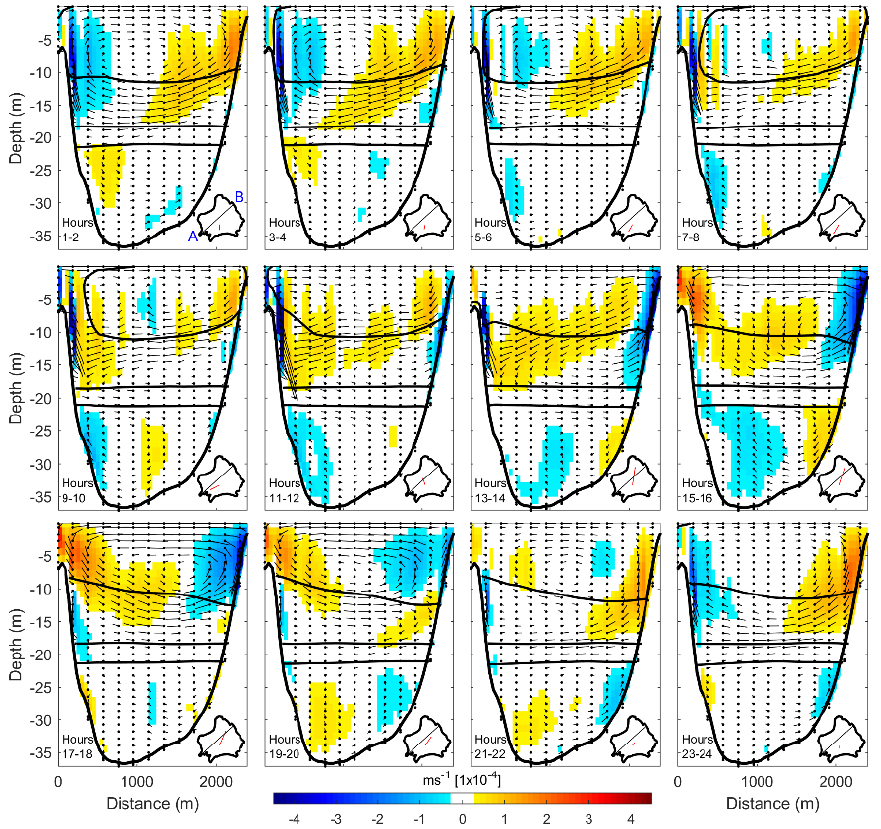
Figure 18. Same as Figure 17 for a vertical transect across Lake Zirahuén. The composites of the simulated velocity current (vectors), vertical velocity component (color), water temperature (contour lines of 18, 20, and 22 °C) and wind speed (vector at the lower right corner of every axes). The transect from A to B in the lower right corner of every axes. The velocity current vectors are shown with a dot at the tail and without arrowhead. The horizontal velocity components were projected onto the main transect.